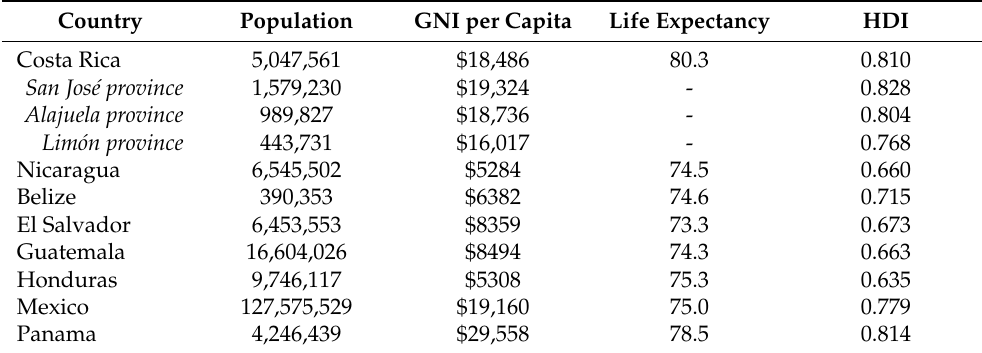
Table 2. Descriptive statistics of Central American countries and the three Costa Rican provinces within which the participants were recruited. The population, Gross National Income (GNI) per capita in thousands of US$ (2011 PPP), life expectancy, and Human Development Index (HDI) are presented for 2019